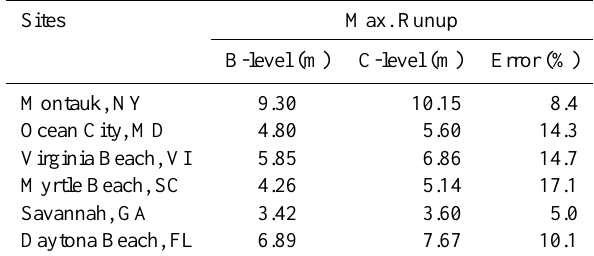
Table 2. Maximum runups on selected sites along the US east coast. Sites Max.